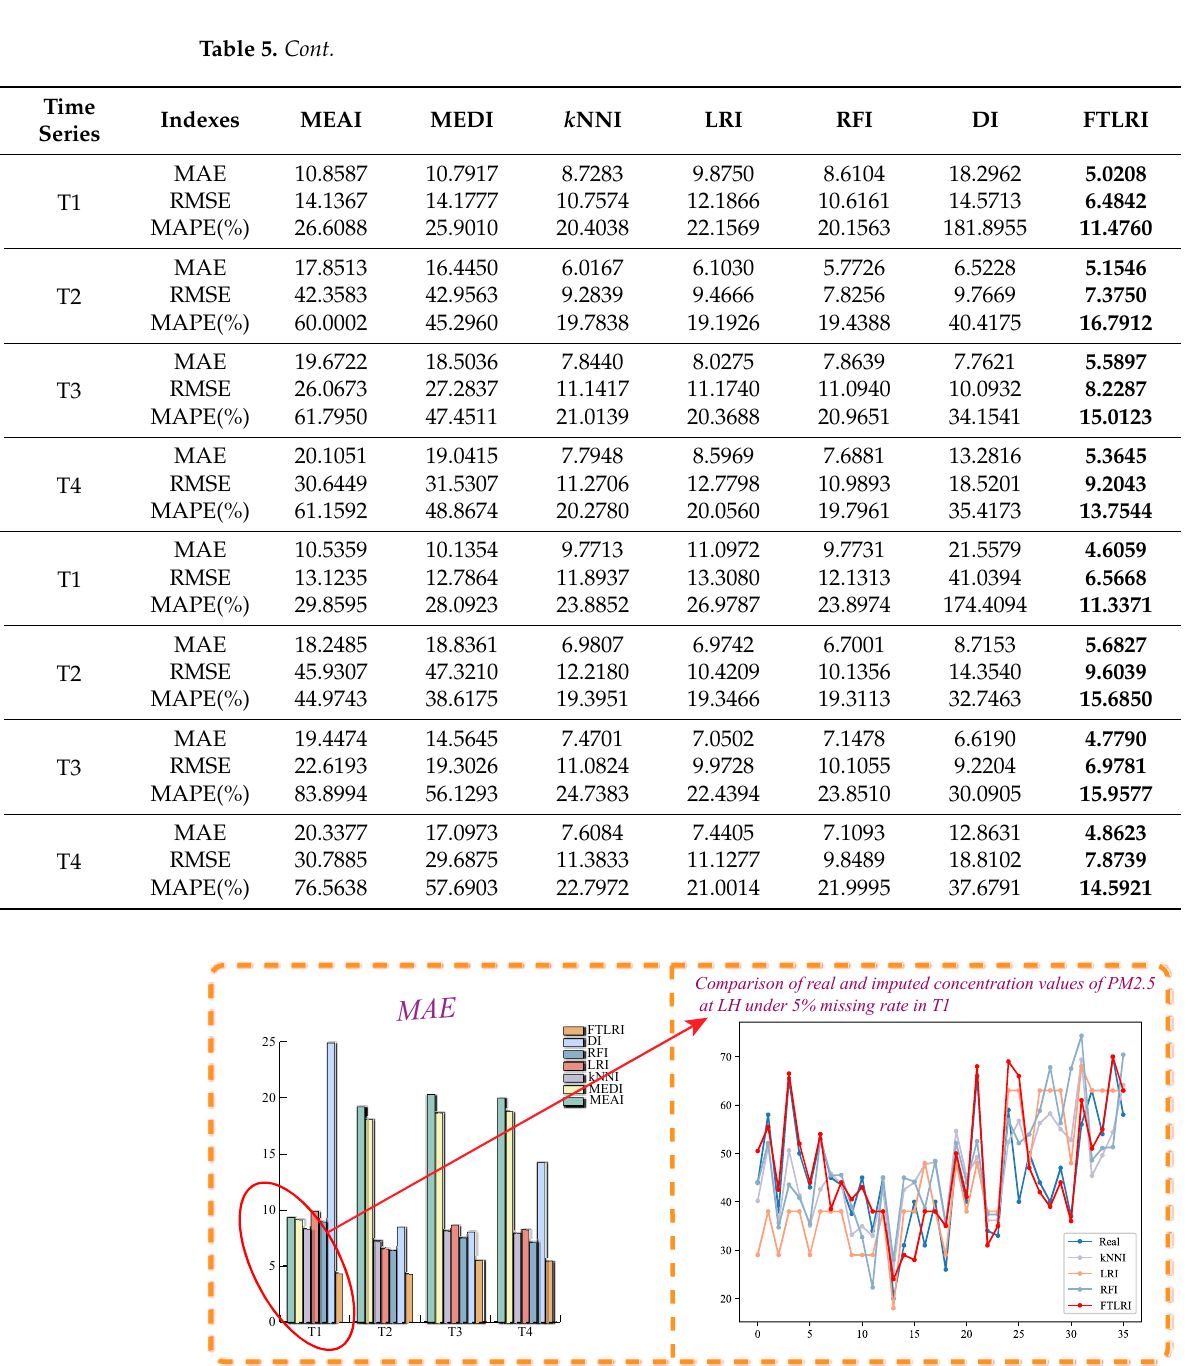
Figure 4. MAE of imputation results of PM 2.5 at LH under 5% missing rate.